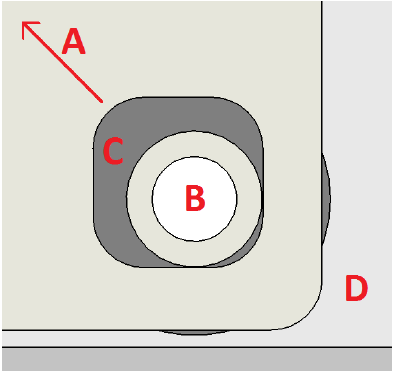
Figure 5. An xy section cut of the squared hole used to allow planar movement of the tool. ( A ) return spring force direction on the fastening plate; ( B ) locking bolt and distance piece; ( C ) low friction pressure distribution washer; ( D ) main tool